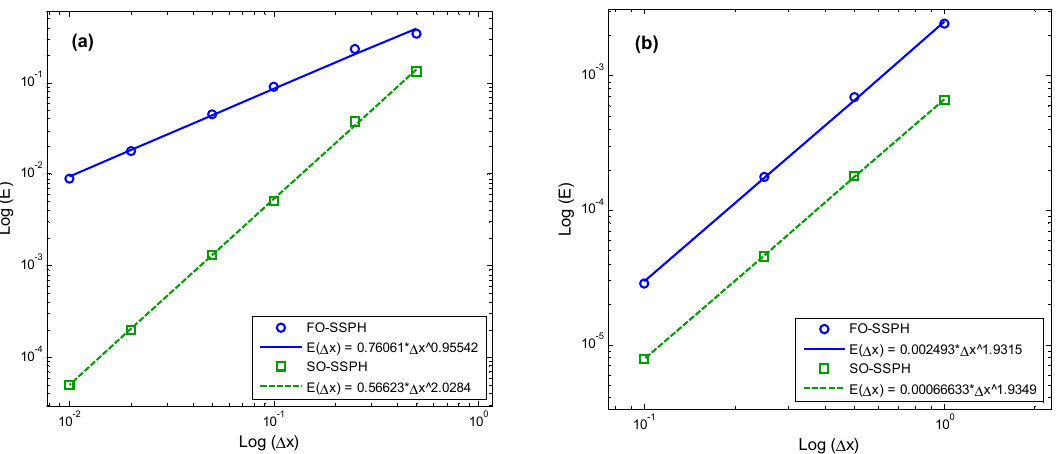
Figure 2. Convergence rate of FO-SSPH and SO-SSPH for solving one-dimensional heat conduction with ( a ) discontinuous initial distribution and ( b ) smooth initial distribution (Gaussian).